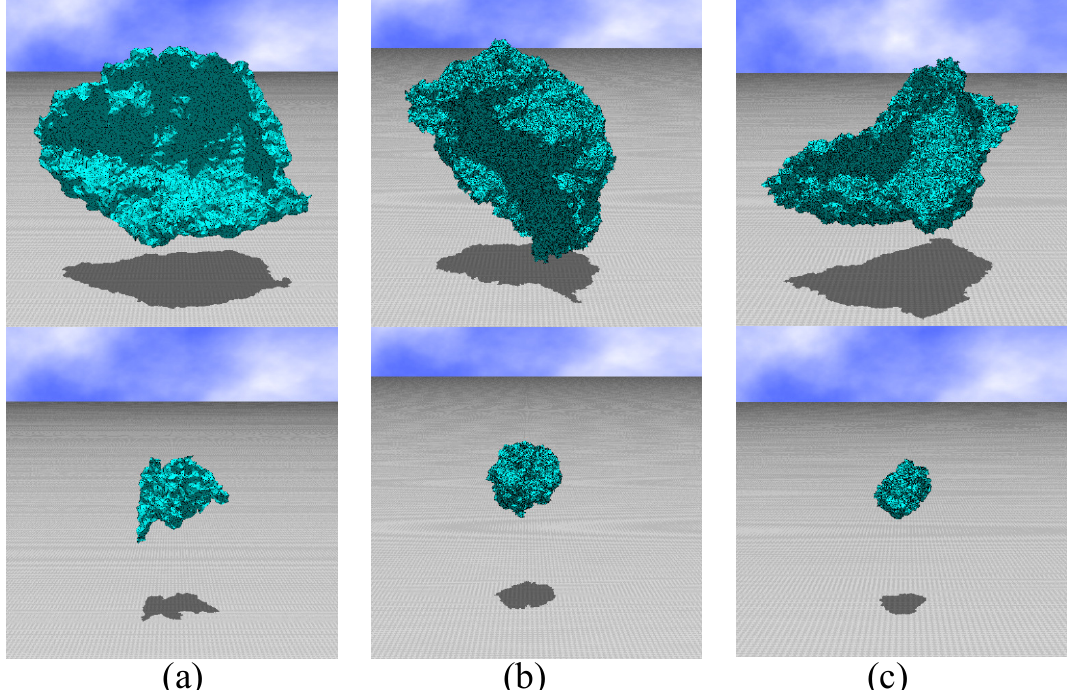
Figure 6. Snapshots of surfaces obtained in the replica i ( ∈ { 1, ··· , N R } ) such that i = N R (= 24 ) in the upper low and i = 1 in the lower low, which correspond to the flat phase and the crumpled phase, respectively, in each model. The models and lattice size N are ( a ) the LG model, N = 7351, ( b ) the canonical model, N = 44,287, and ( c ) the modified canonical model, N =